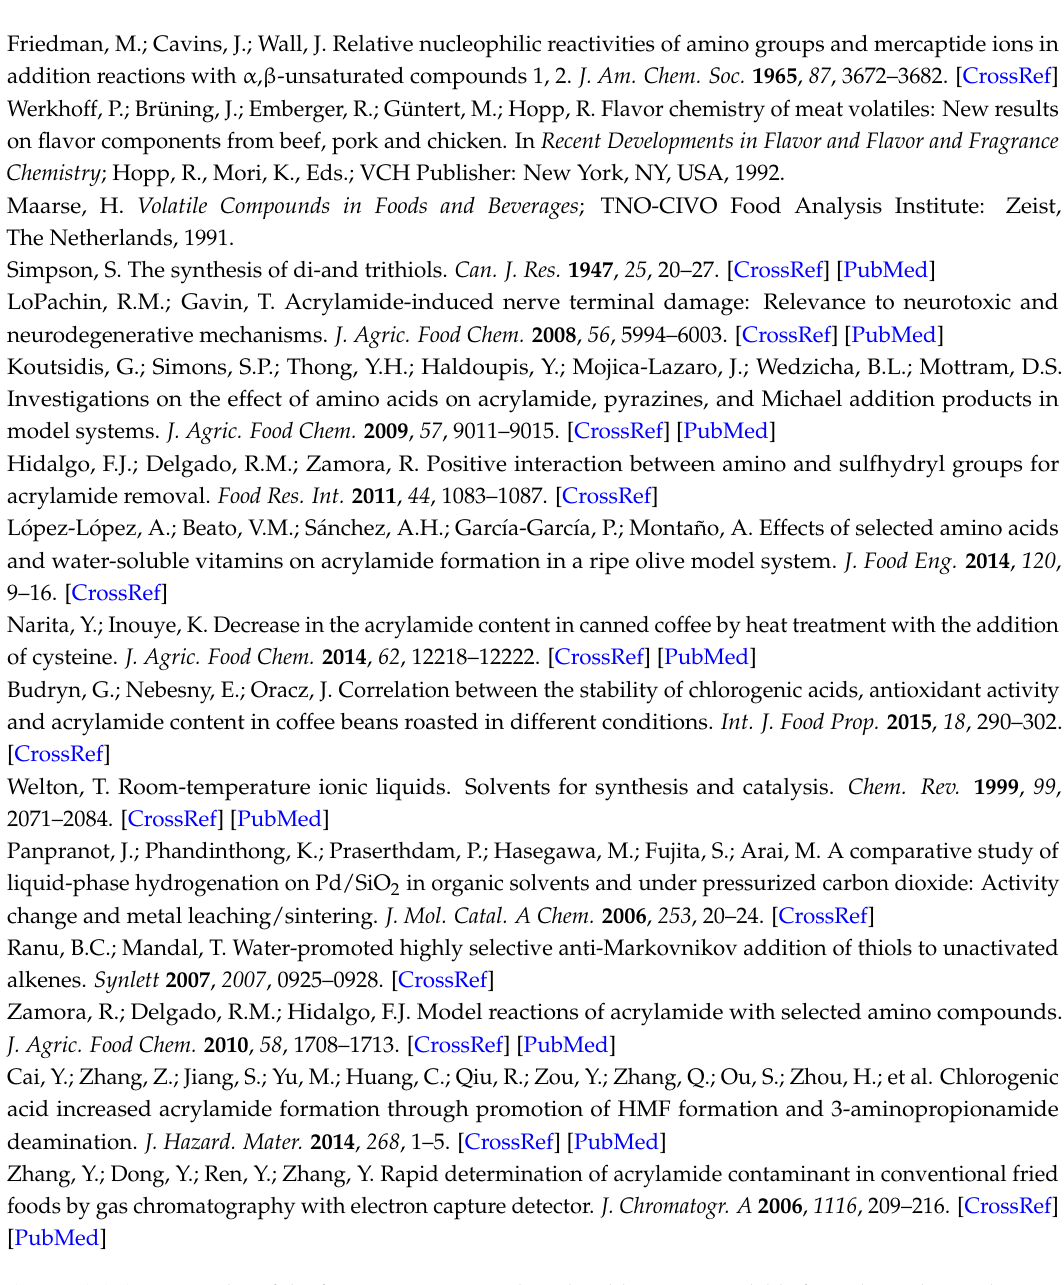
Sample Availability: Samples of the four mercaptan-acrylamide adducts are available from the authors. They are all white crystals, and the spectroscopic datas are in the